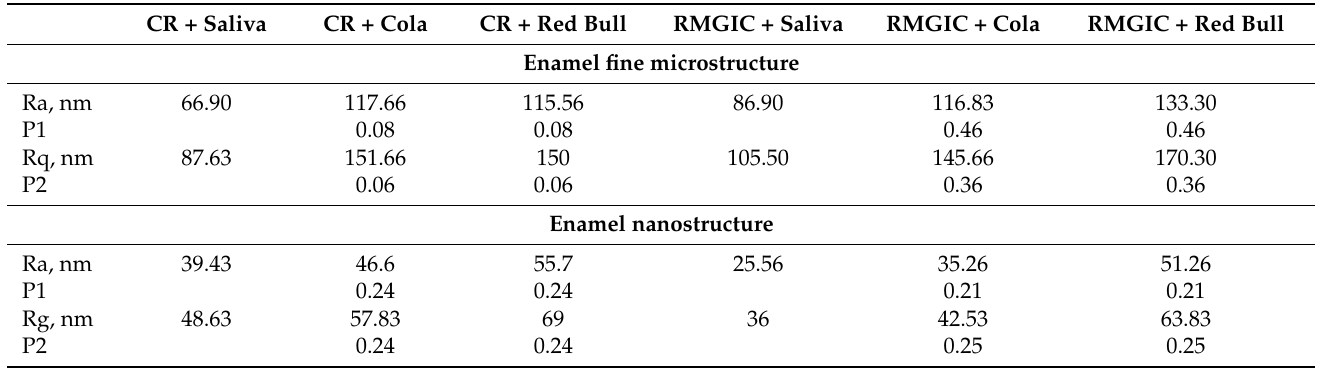
Table 2. Surface roughness statistical analysis for the samples after